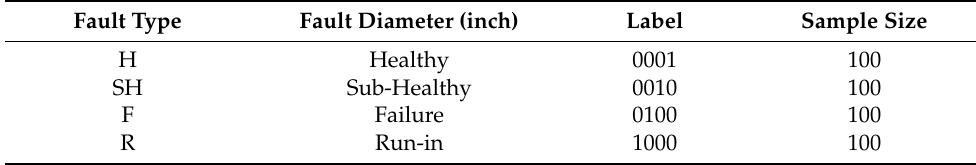
Table 1. Four types of fault status